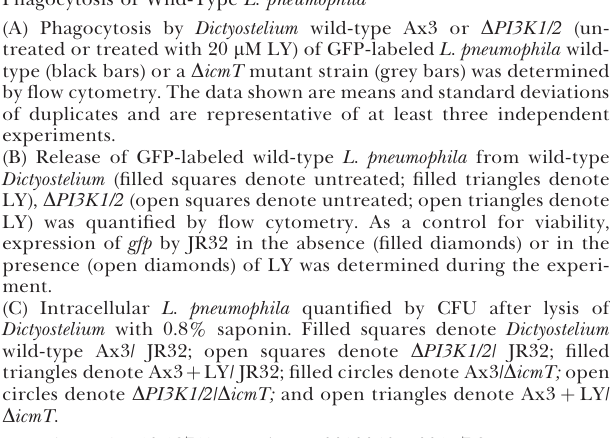
Figure S1. A Role for PI3Ks in Intracellular Replication but Not Phagocytosis of Wild-Type L. pneumophila (A) Phagocytosis by Dictyostelium wild-type Ax3 or D PI3K1/2 (un- treated or treated with 20 l M LY) of GFP-labeled L. pneumophila wild-